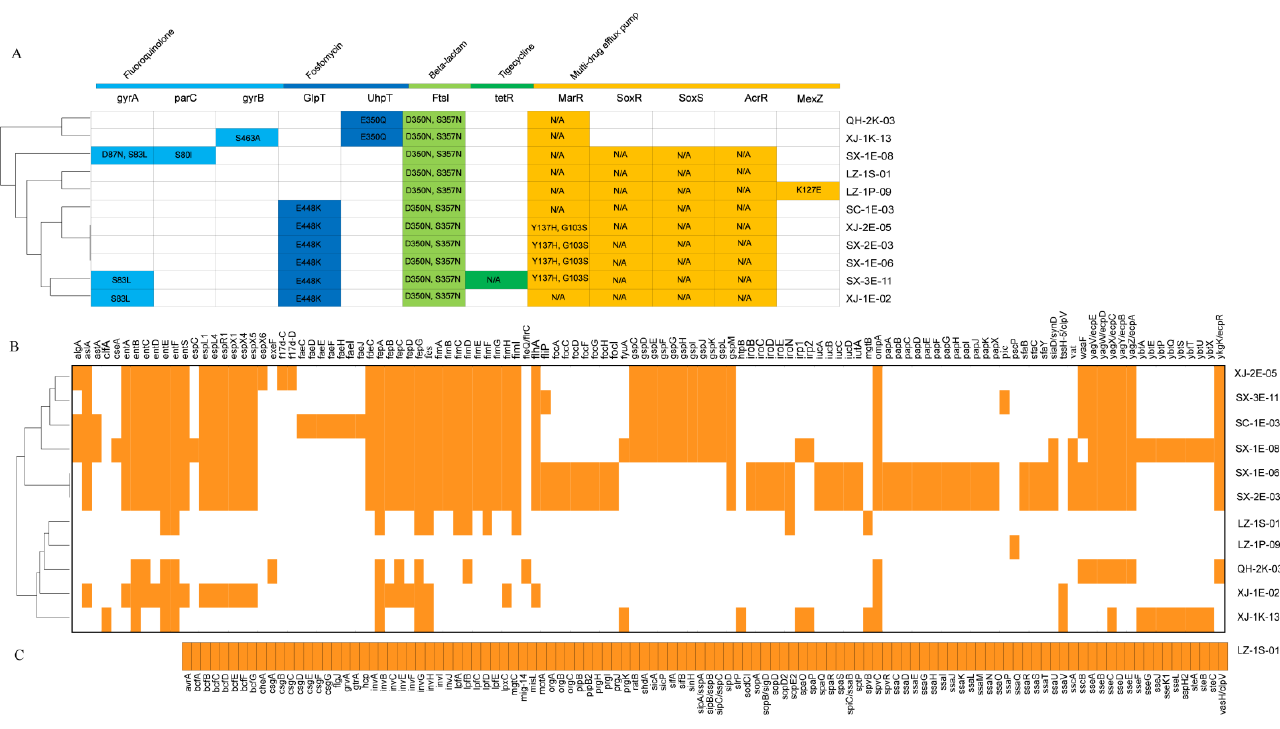
Figure 3. The acquired antimicrobial resistance (AMR) gene and virulence genes of tigecycline-resistant isolates with whole-genome sequences. ( A ) Various types of AMR genes are labeled with different colors. White squares indicate no AMR genes. ( B ) Cluster analysis of common virus gene; ( C ) LZ-1S-09 specific virulence gene profiles. Colored squares represent virulence genes, and white squares indicate no virulence gene.